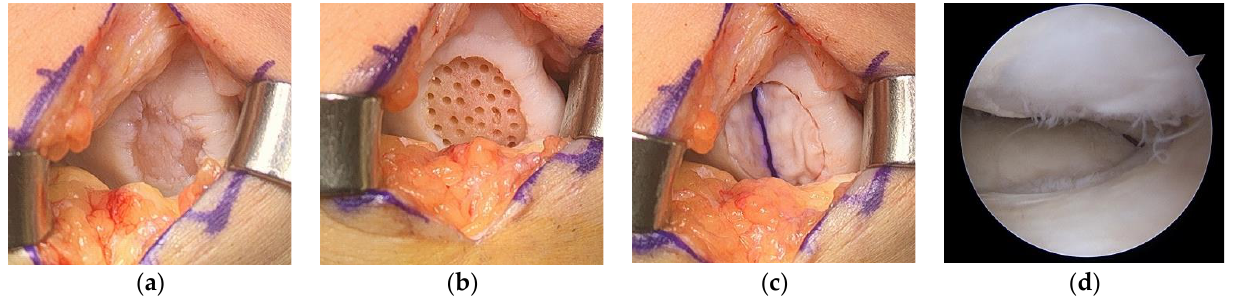
Figure 5. ( a ) Cartilage defect, ( b ) after defect preparation, ( c ) membrane-covered defect, and ( d ) second-look arthroscopy 2 years later. * Image courtesy of Prof. Sung-Hwan Kim